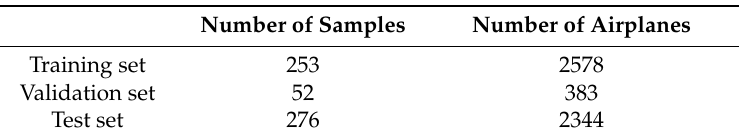
Table 1. The dataset